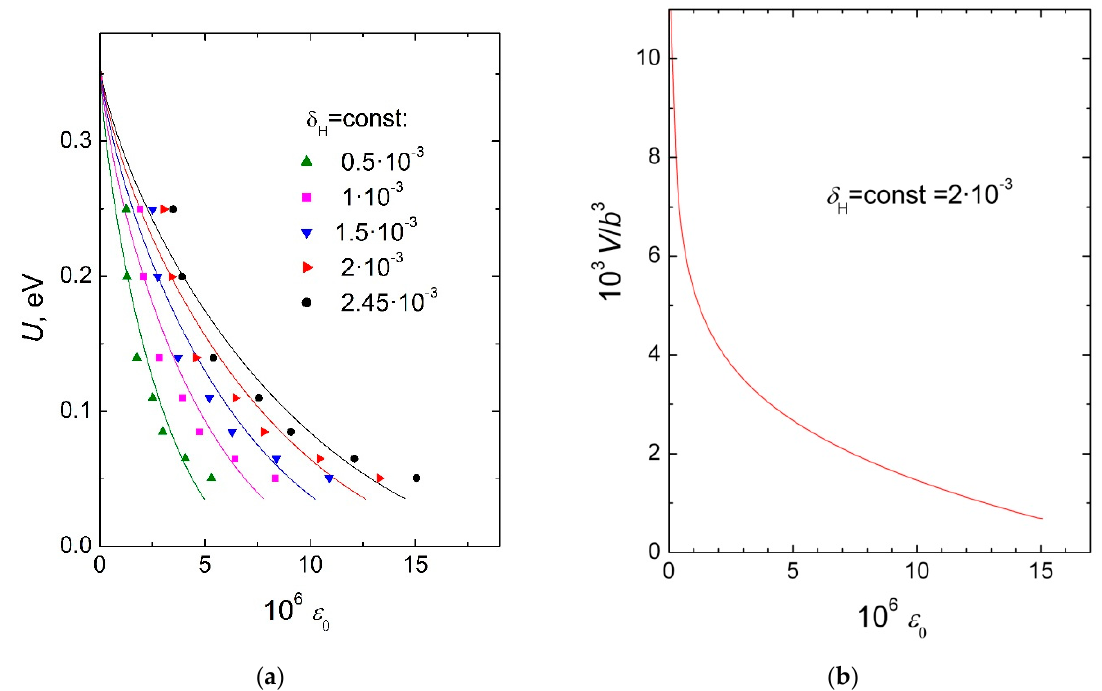
Figure 8. Dependences ( a ) of the activation energy U on amplitude ε 0 for several sections δ H ( T , ε 0 ) = const and ( b ) the activation volume V for the section δ H ( T , ε 0 ) = 2 × 10 –3 for the extruded sample.